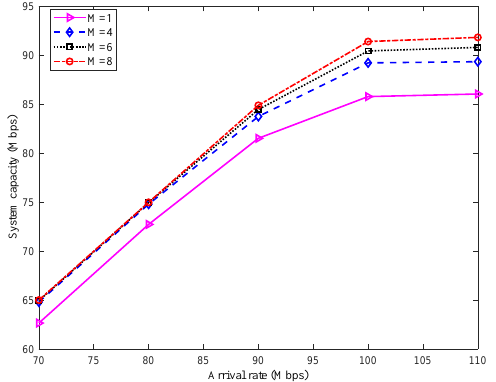
Figure 4. System capacity of different number of DRSs in Scenario